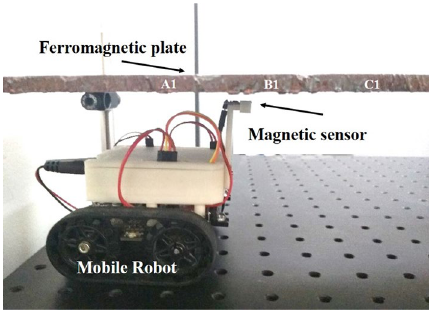
Fig. 11 Arrangement implemented for defect measurement on the ferromagnetic board